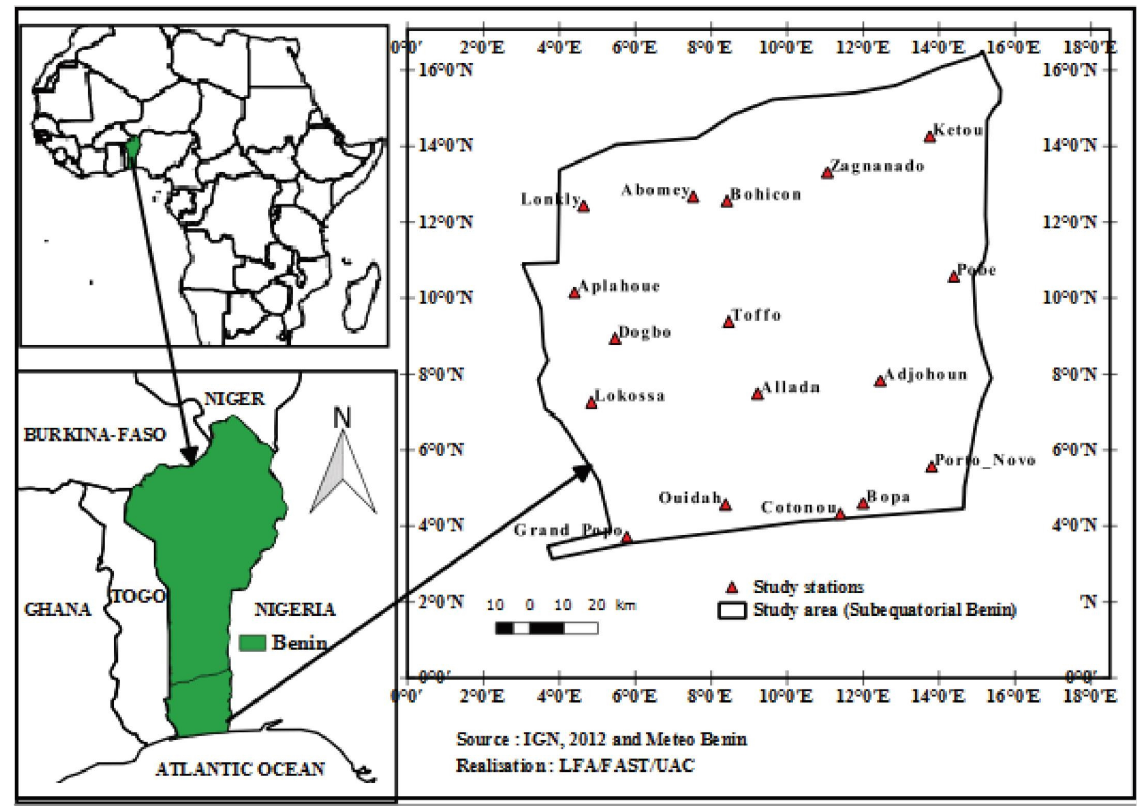
Figure 1: Locations of weather stations in southern Benin in